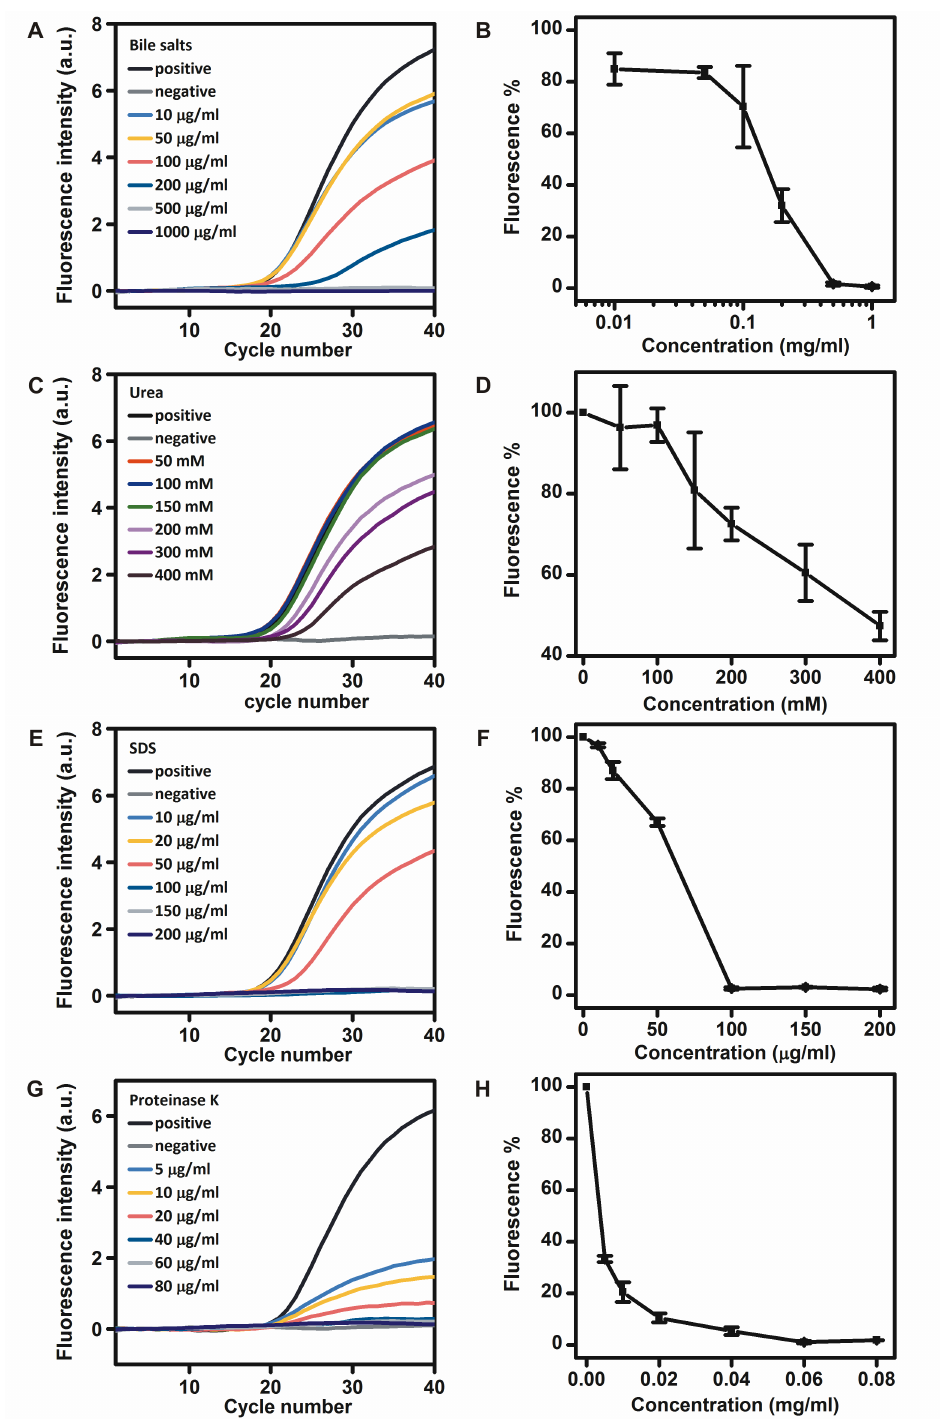
Fig 3. Inhibitory effects of different concentrations of bile salts A, B), urea C, D), SDS E, F), and proteinase K G, H) on the RNA detection by r Tth polymerase.